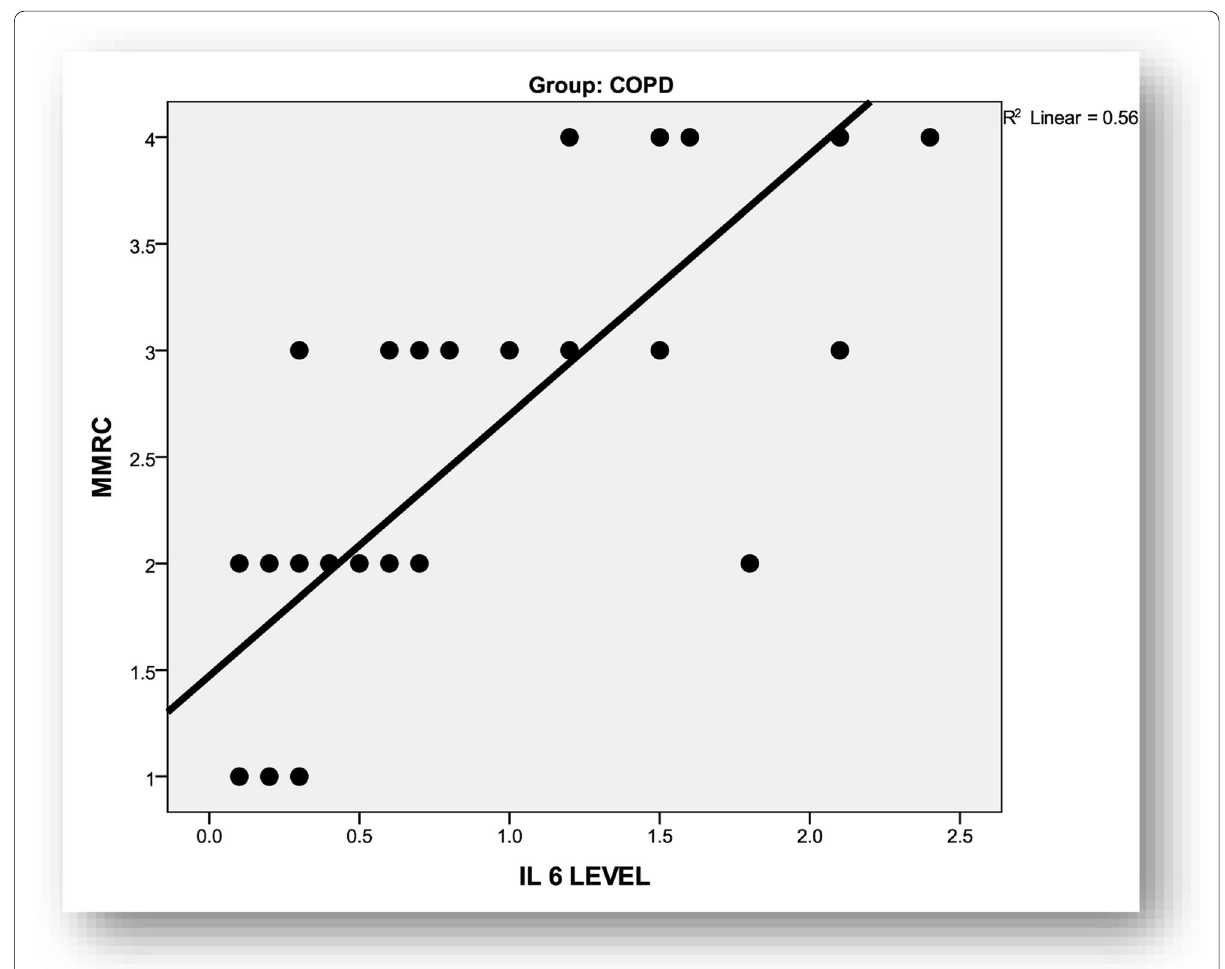
Fig. 5 Correlation between IL‑6 level with MMRC among cases of